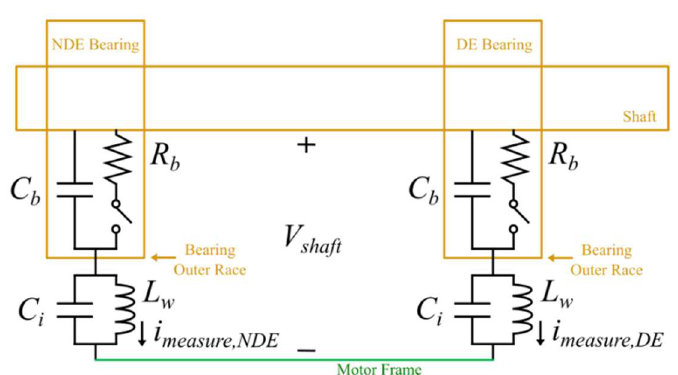
Figure 4. Circuit model of EDM bearing current paths in an electric machine with the effects of motor modification for bearing current measurement included. For an unmodified machine, the components C i and L w are not a part of the discharge path.